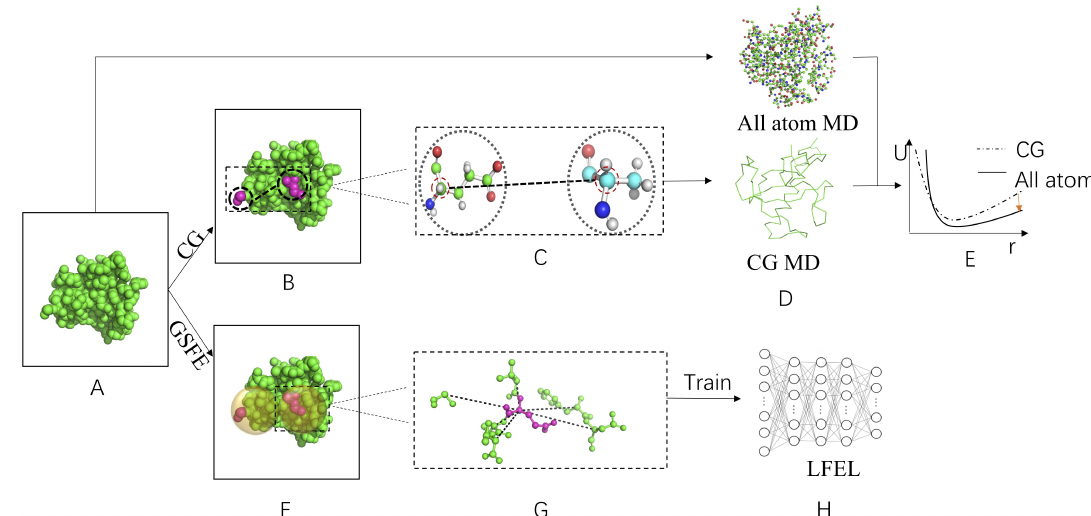
Figure 4. Schematic illustration of difference between CG and GSFE implementation of LFEL using protein as an example. ( A ) Target molecular systems in physical space. Due to the goal of constructing partially transferable models and/or force fields, usually many different but similar molecular systems are considered. ( B ) Selection of local atom/particle clusters to be represented as one particle in CG model. ( C ) Selection of CG sites. ( D ) Comparison between atomistic (or higher resolution) simulation results and CG (lower resolution) results. ( E ) Adjust of CG FF parameter according to comparison from ( D ). ( F ) Definition of solvent region for each solute unit. ( G ) Feature extraction for each solute. ( H ) “Caching” of LFEL with neural network by training with prepared data